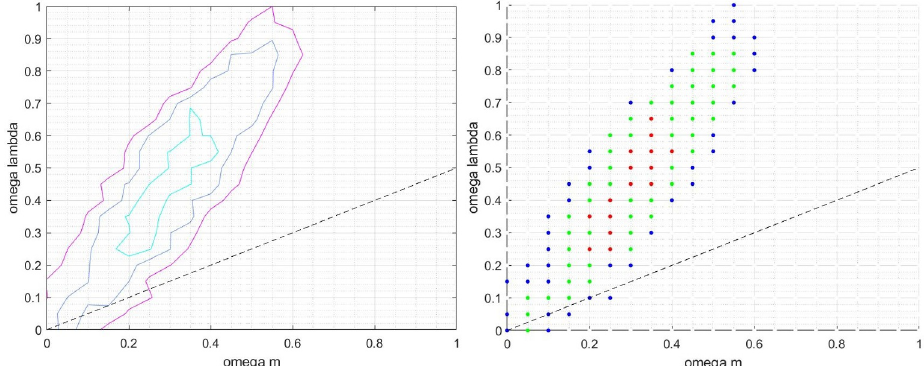
Figure 2: Contour plot (left) and scatter plot (right) of Ω m against Ω Λ for the Λ CDM model, using the MLE and MCMC method, with 1 σ , 2 σ and 3 σ lines drawn. The dotted line rep- resents the line of no acceleration. The best fit values of Ω m and Ω Λ are 0.40 and 0.55 respectively, with a minimum χ 2 value of − 231 . 209.